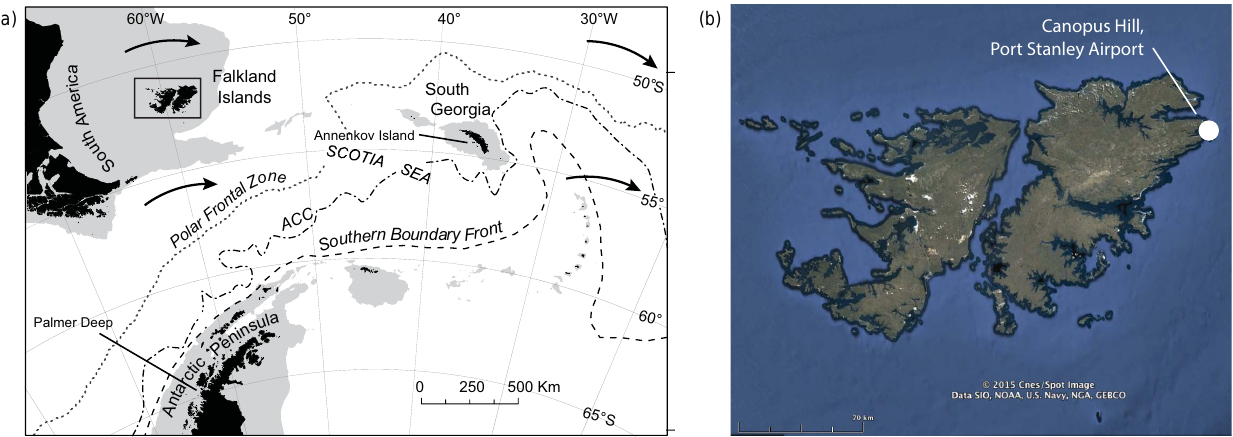
Figure 1. Location of the Falkland Islands in the South Atlantic Ocean with mean locations of the Polar and Southern Boundary fronts (dashed lines), the continental shelf (grey areas), and prevailing westerly airflow (solid arrows) (a) ; and Canopus Hill, Port Stanley Airport, in the east Falkland Islands (b) . (a) was modified from Strother et al. (2015) and (b) was obtained from Google Earth.